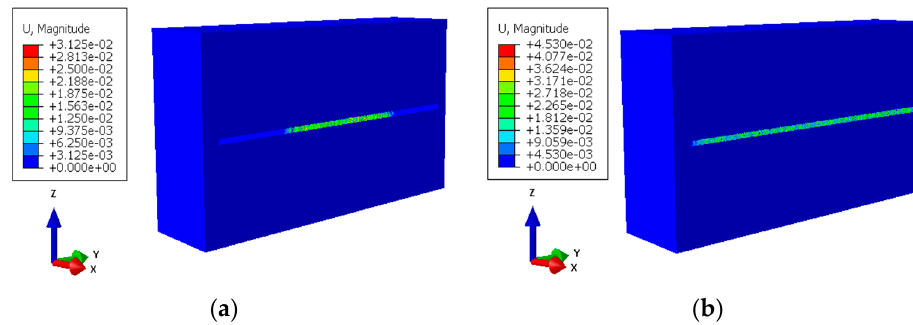
Figure 4. Transmission of explosive deflagration within the radial borehole: ( a ) initial state of explosive deflagration; ( b ) transmission of explosive deflagration.